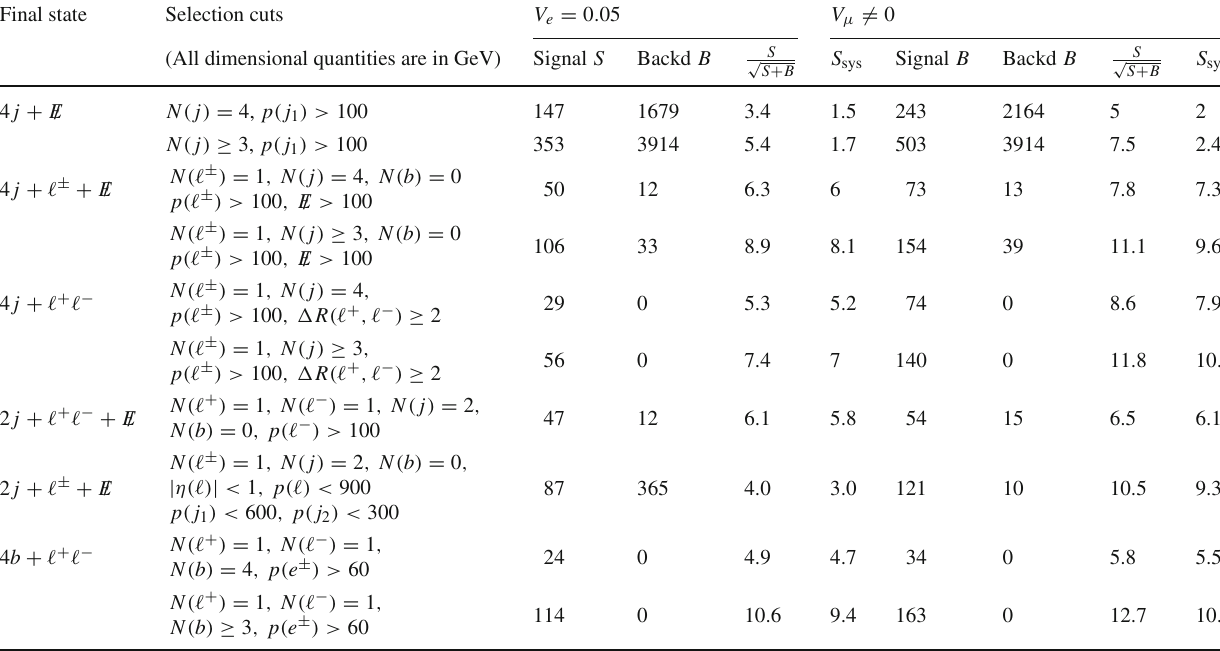
Table 7 Number of surviving events, and signal significance for different final states arising from the pair production of (cid:2) ± (cid:2) ∓ at 300 f b − 1 √ s = 2 TeV, and M (cid:2) = 500 GeV. S sys corresponds to the signal significance with assumed systematics according to Eq. (7) luminosity at Final